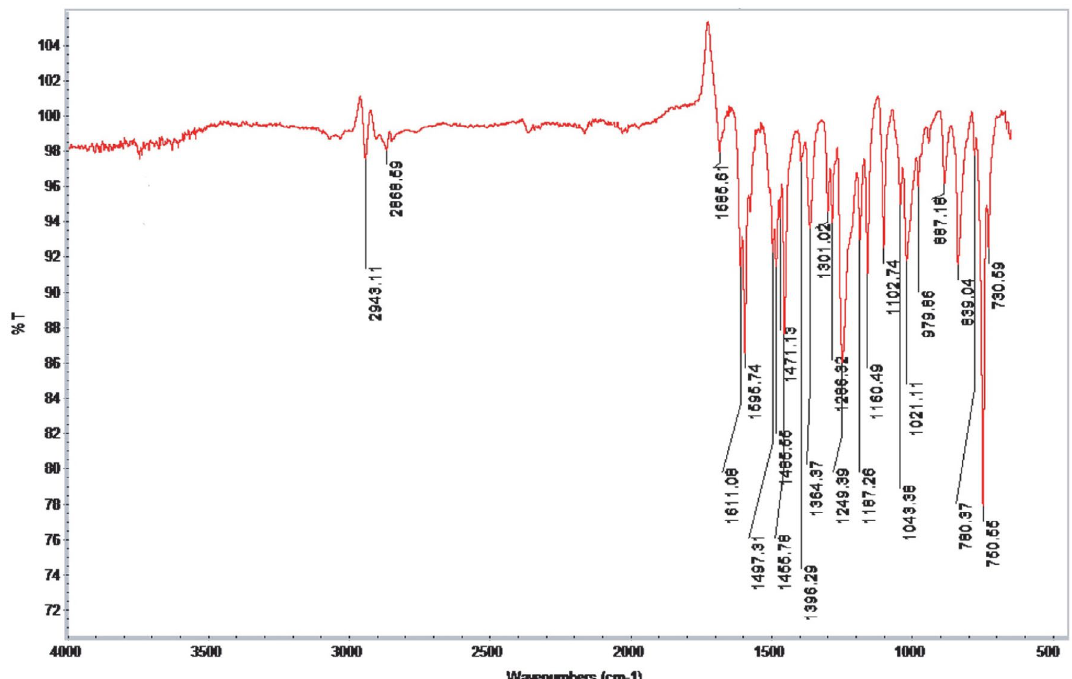
Figure 2 . FT-IR spectrum of polymer P o HOBPD, conditions as